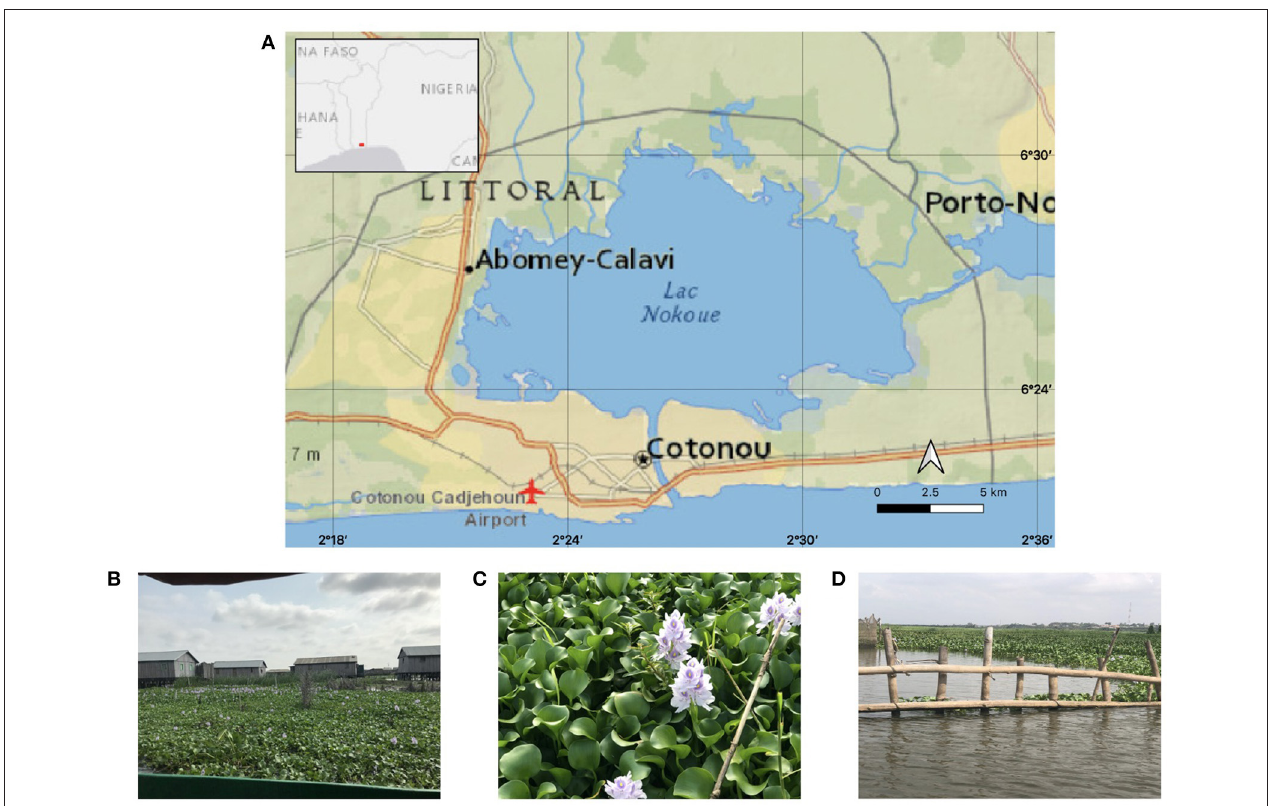
FIGURE 3 | Map of Lake Nokoue in Benin (A) with images of water hyacinth (B,C) and acadja fishing ponds (D) . Credit: The